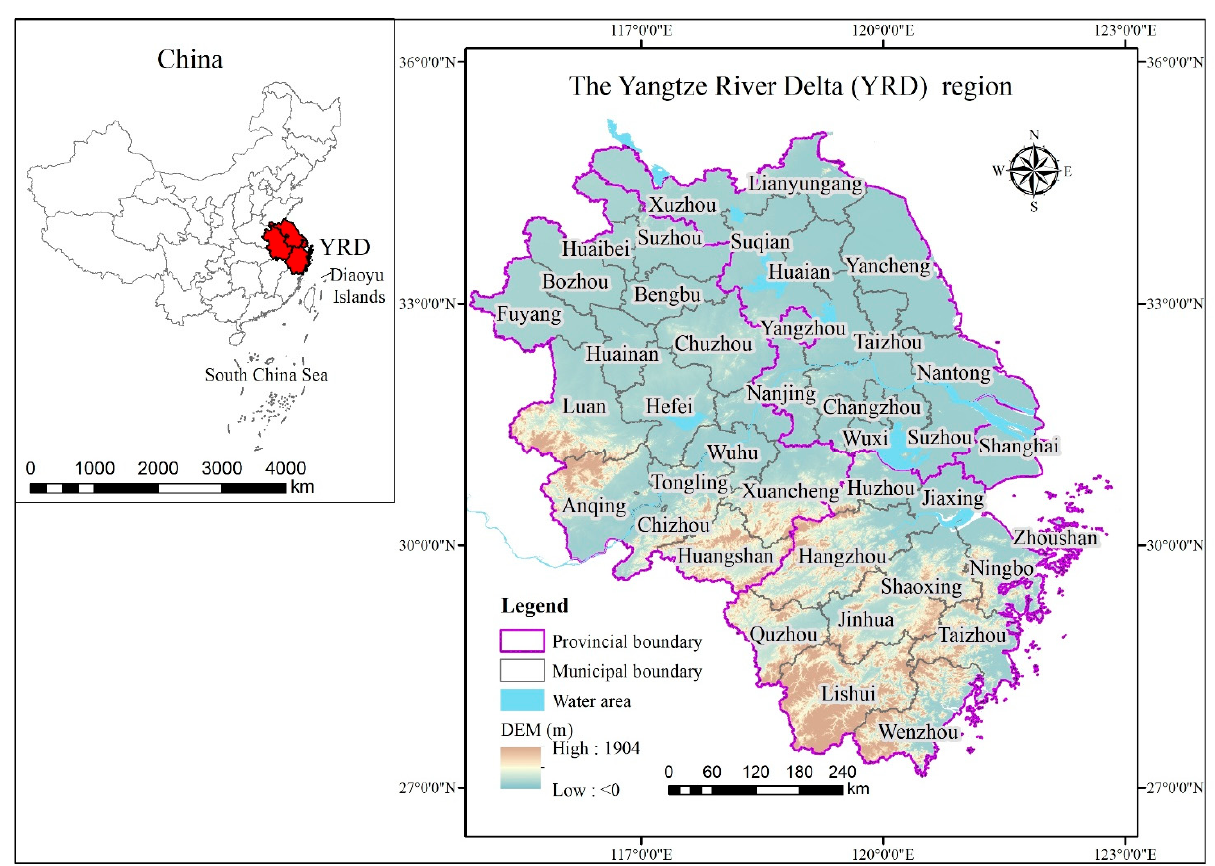
Figure 2. Location map and administrative division of the YRD.